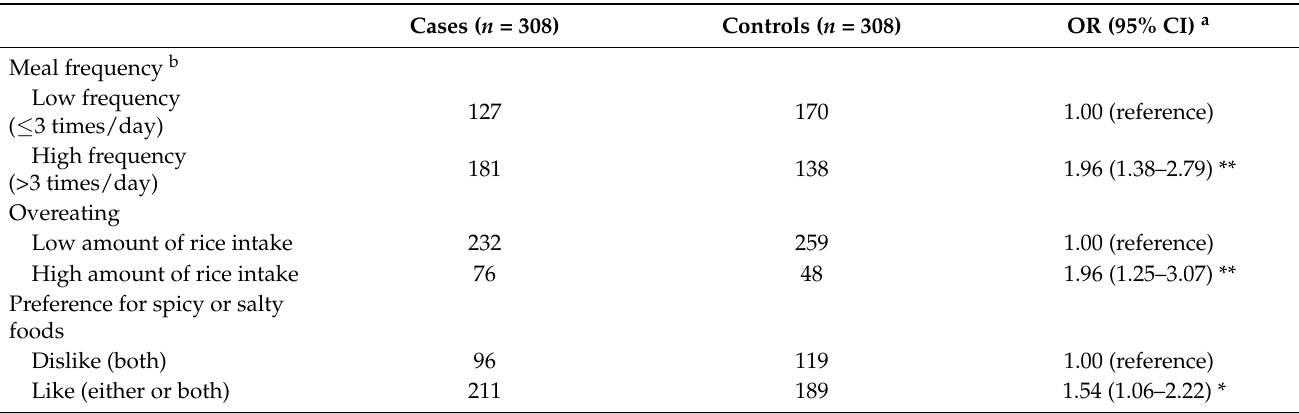
Table 3. Odds ratios (ORs) and 95% confidence intervals (95% CIs) of gastric cancer by dietary factors irritating the stomach